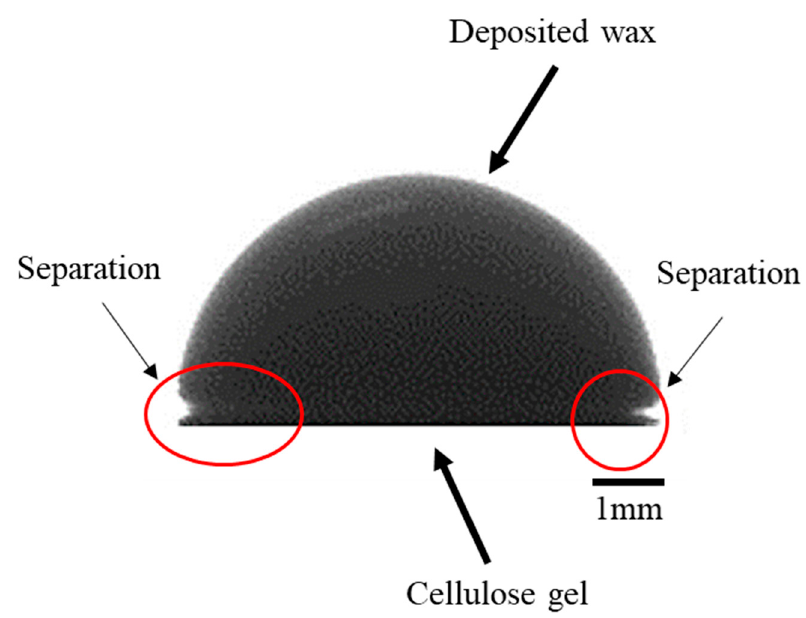
Figure 4. Image of a droplet of melted wax (Solidscape®) at 70 °C deposited on cellulose gel.